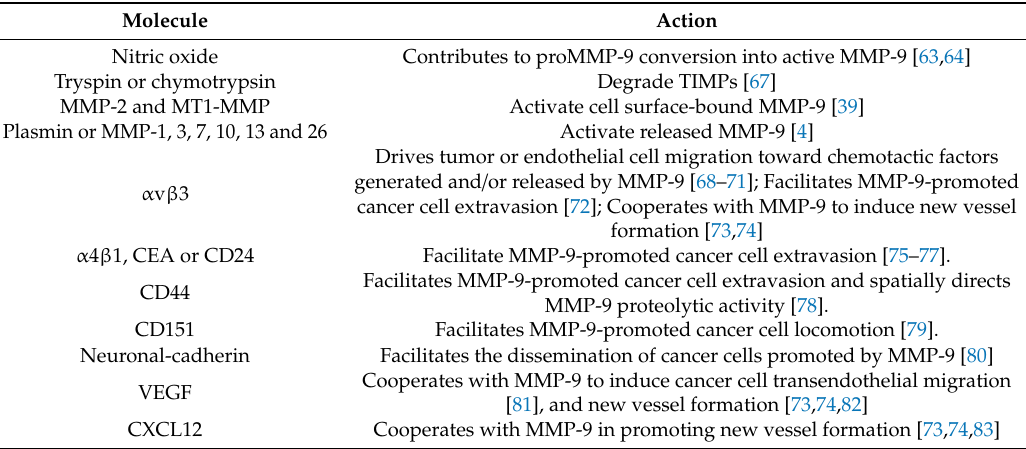
Table 1. Molecules enhancing MMP-9 activity in tumor